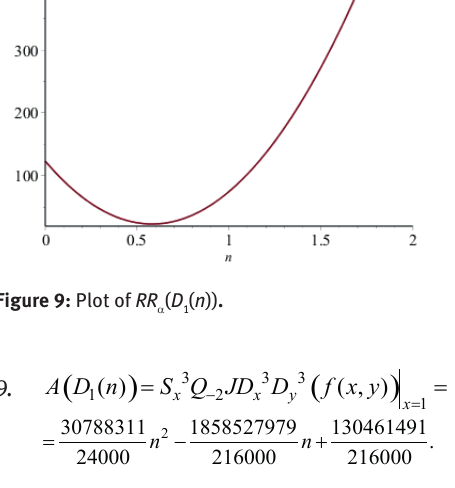
Figure 8: Plot of R ( ) 1 1